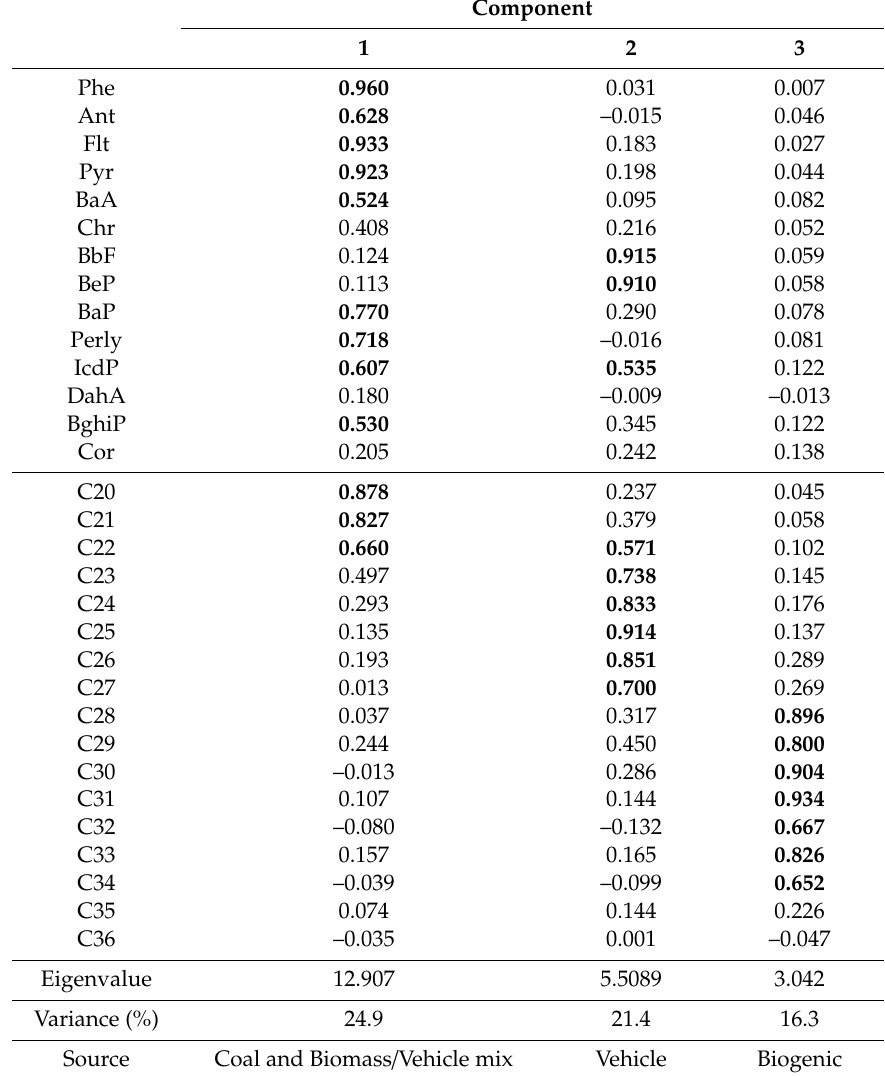
Table 8. Principle Component Analysis(PCA) factor loadings (only the values larger than 0.5 were marked as bold) for the entire sampling